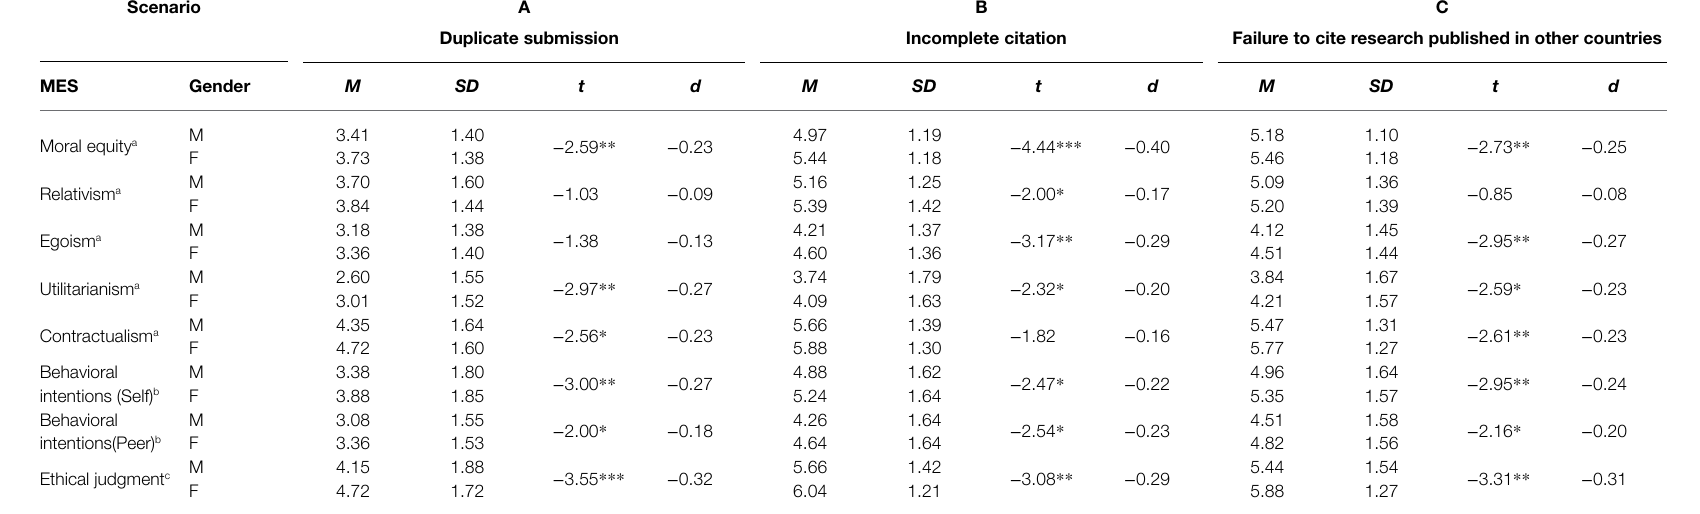
TABLE 3 | Gender differences in responses across AD